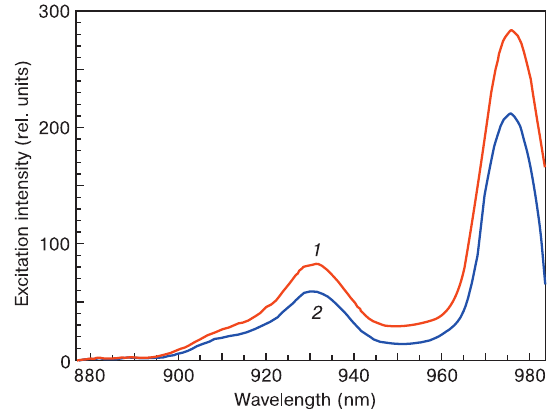
Yb Na )Ga O luminophore specimen exci- 0,9 0,05 0,05 2 4